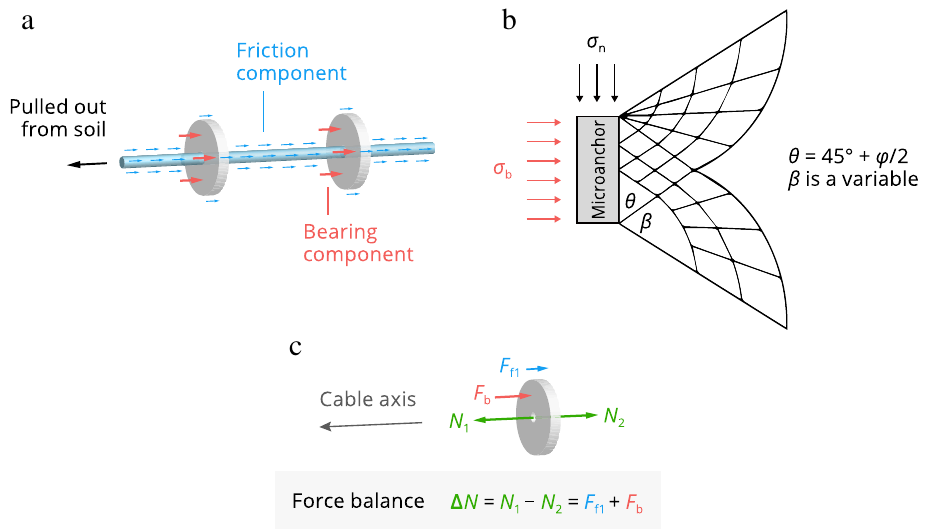
Figure 2. Interaction between soil and microanchored fiber-optic cable, illustrated with an example of disc- shaped microanchors. ( a ) Resistive force components for cable pulled out from soil. ( b ) Modified punching shear failure mechanism of microanchor (after ref 29 ). ( c ) Force diagram of a single